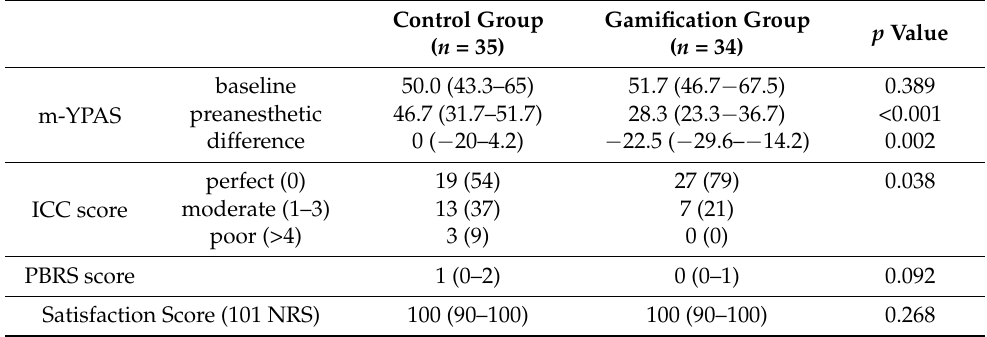
Table 2. Preoperative anxiety, induction compliance, and stressful behaviors of children and parental